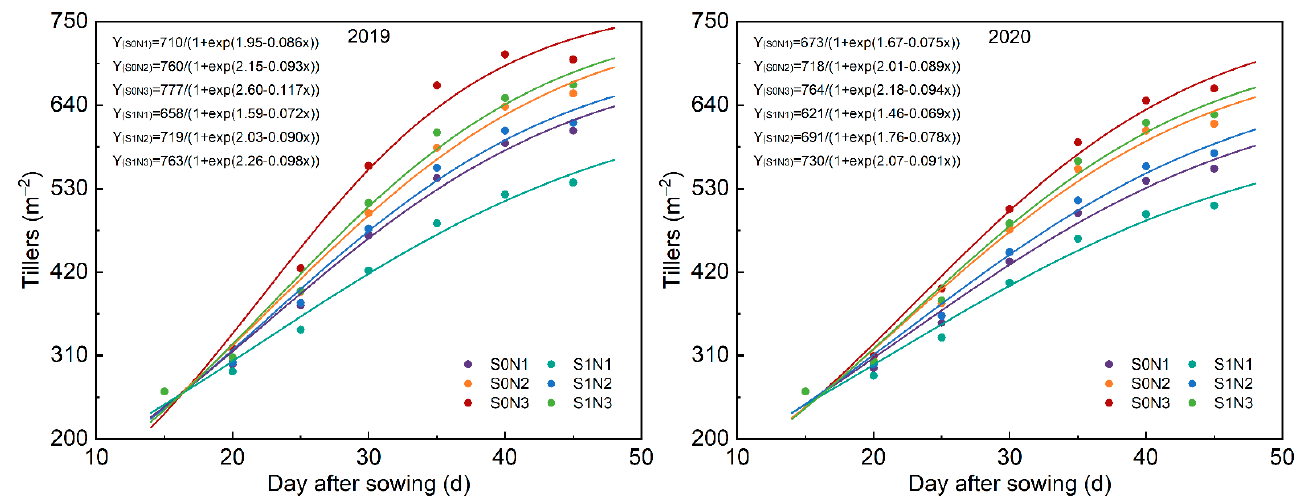
Figure 5. Tillering dynamics under wheat straw returning coupled with early N management in 2019 and 2020. S0 and S1 represent treatment without wheat straw returning and treatment with wheat straw returning, respectively. N1, N2, and N3 represent early N management of 65 kg N ha − 1 , 95 kg N ha − 1 , and 125 kg N ha − 1 , respectively. The information on these treatments was shown in Table 1.